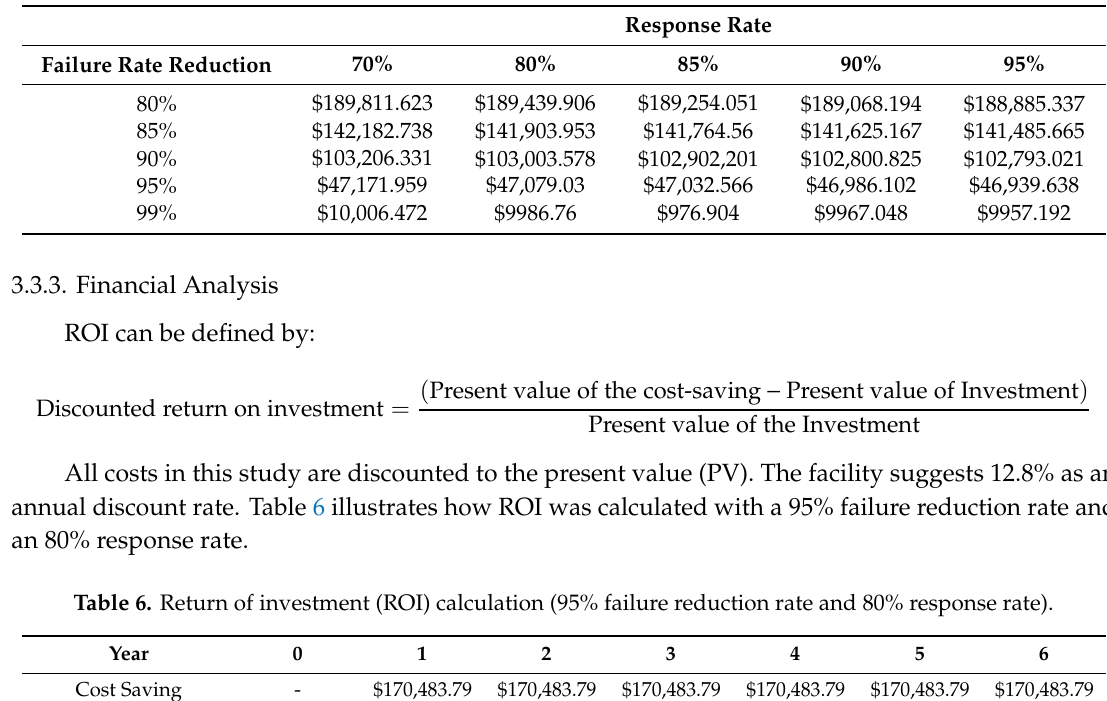
Table 5. The average annual cost for the di ff erent rates of failures and responses.